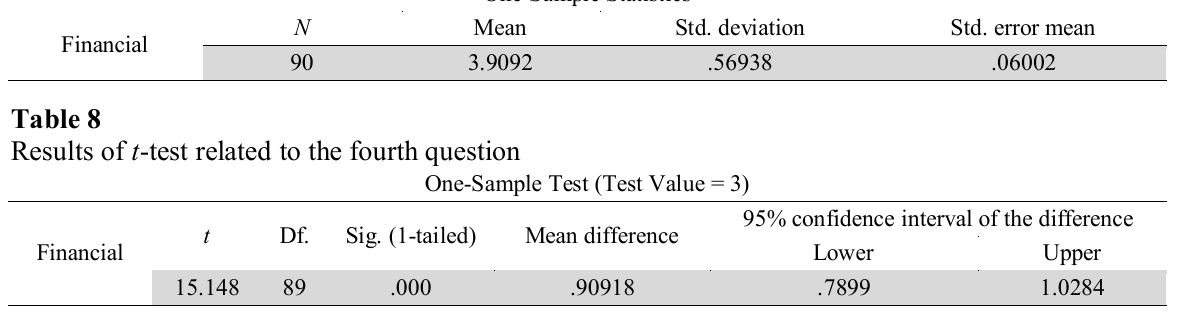
Results of descriptive statistics related to the financial aspect